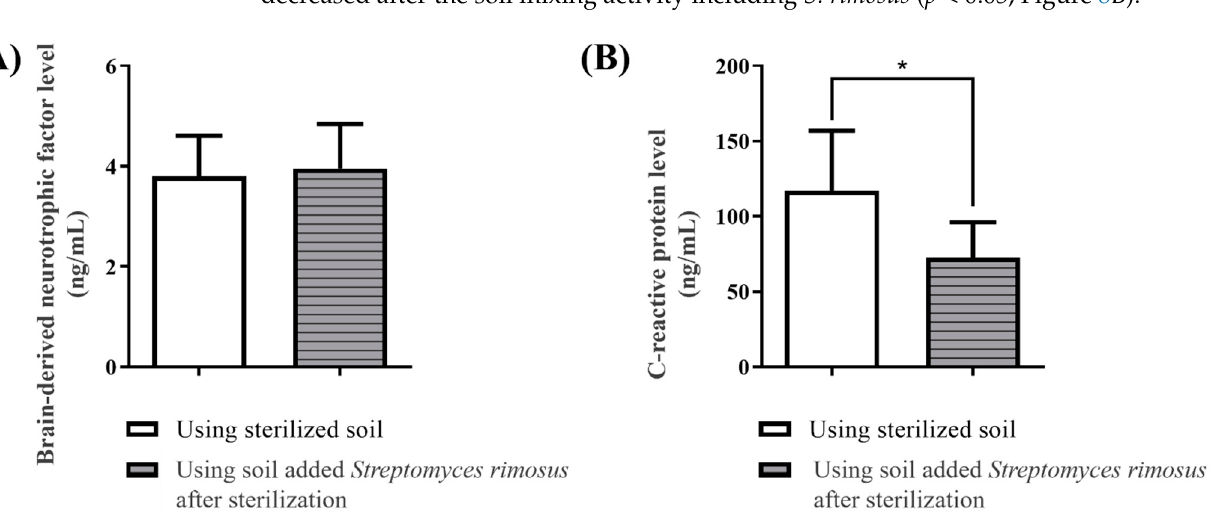
Figure 8. Results of ( A ) BDNF and ( B ) CRP levels in serum after the soil mixing activity with or without S. rimosus (n = 16 per group). Data were analyzed via paired t -test. * p < 0.05 compared to the sterilized soil group. Values are the mean ± SD.